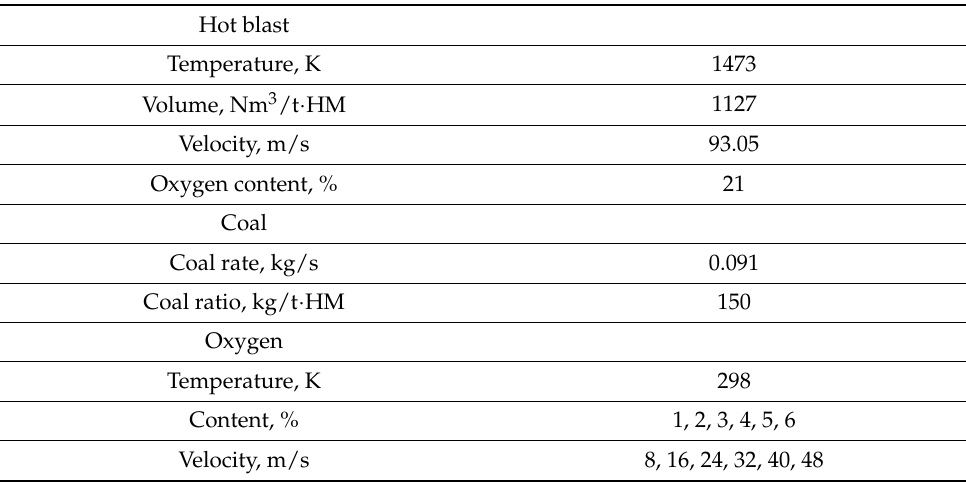
Table 1. The coal burnout of different numbers of meshes: ( a ) Base case; ( b ) targeted oxy- gen-enrichment.